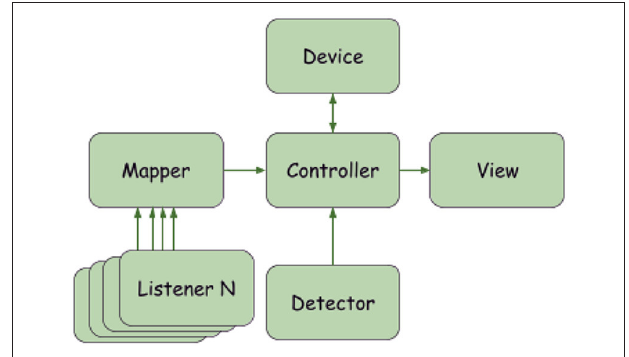
FIGURE 1 | A Block diagram illustrating the functioning and main components of the dAIsy